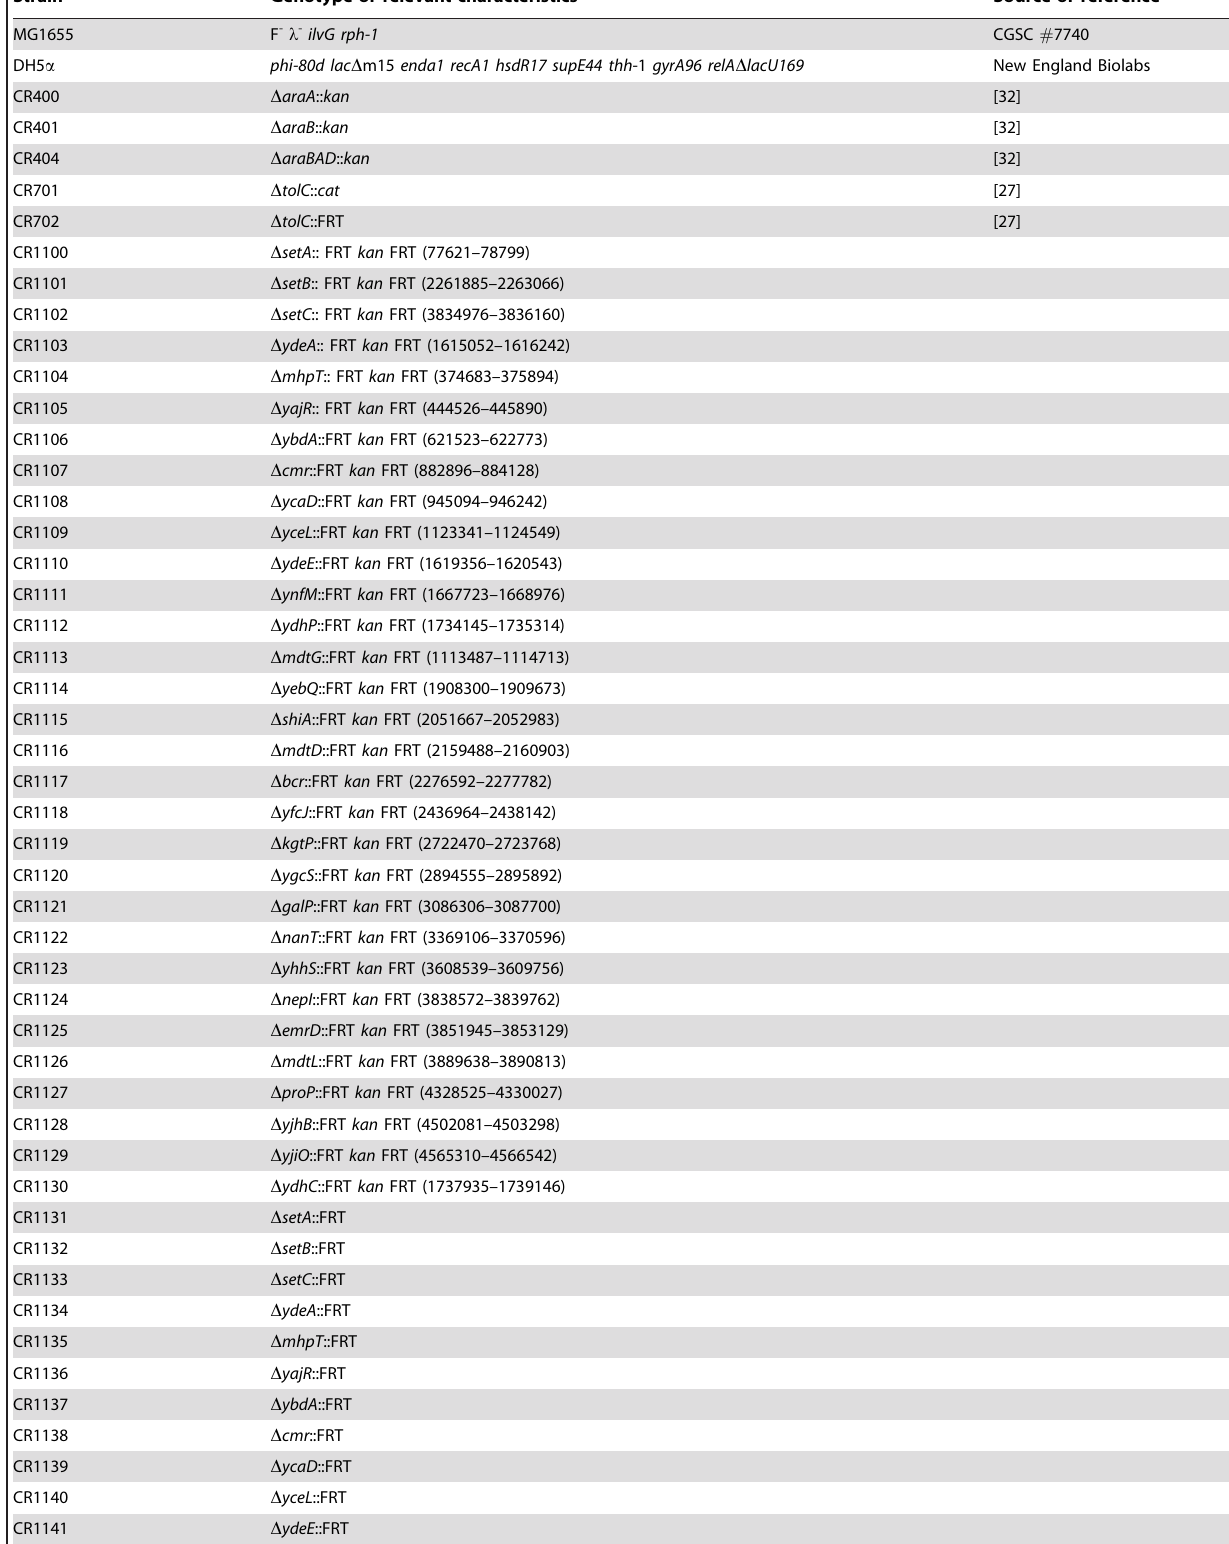
Table 3. Bacterial strains used in this work.